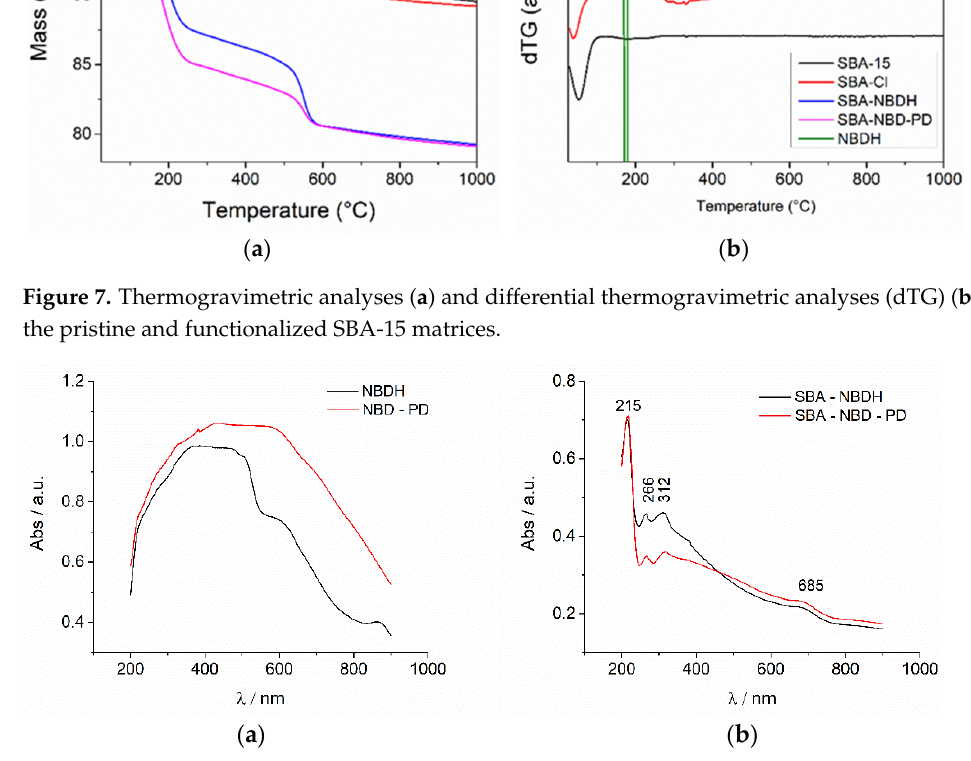
Figure 8. Absorption spectra of NBDH/NBD-PD ( a ) and SBA-NBDH/SBA-NBD-PD ( b